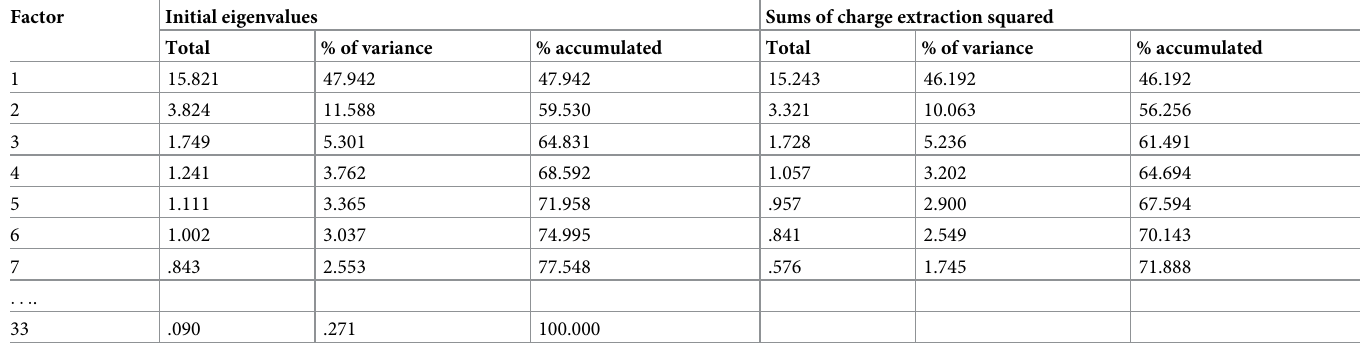
Table 5. Total variance explained and goodness-of-fit